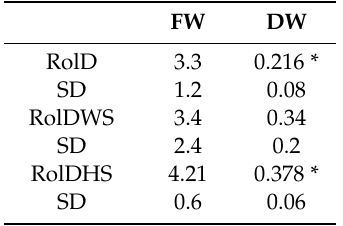
Table 1. Mean fresh weight (FW), mean dry weight (DW), and standard deviations (SD) of RolD: non- stressed transgenic plants; RolDWS: transgenic plants exposed to water stress; and RolDHS: transgenic plants exposed to heat stress samples (g).